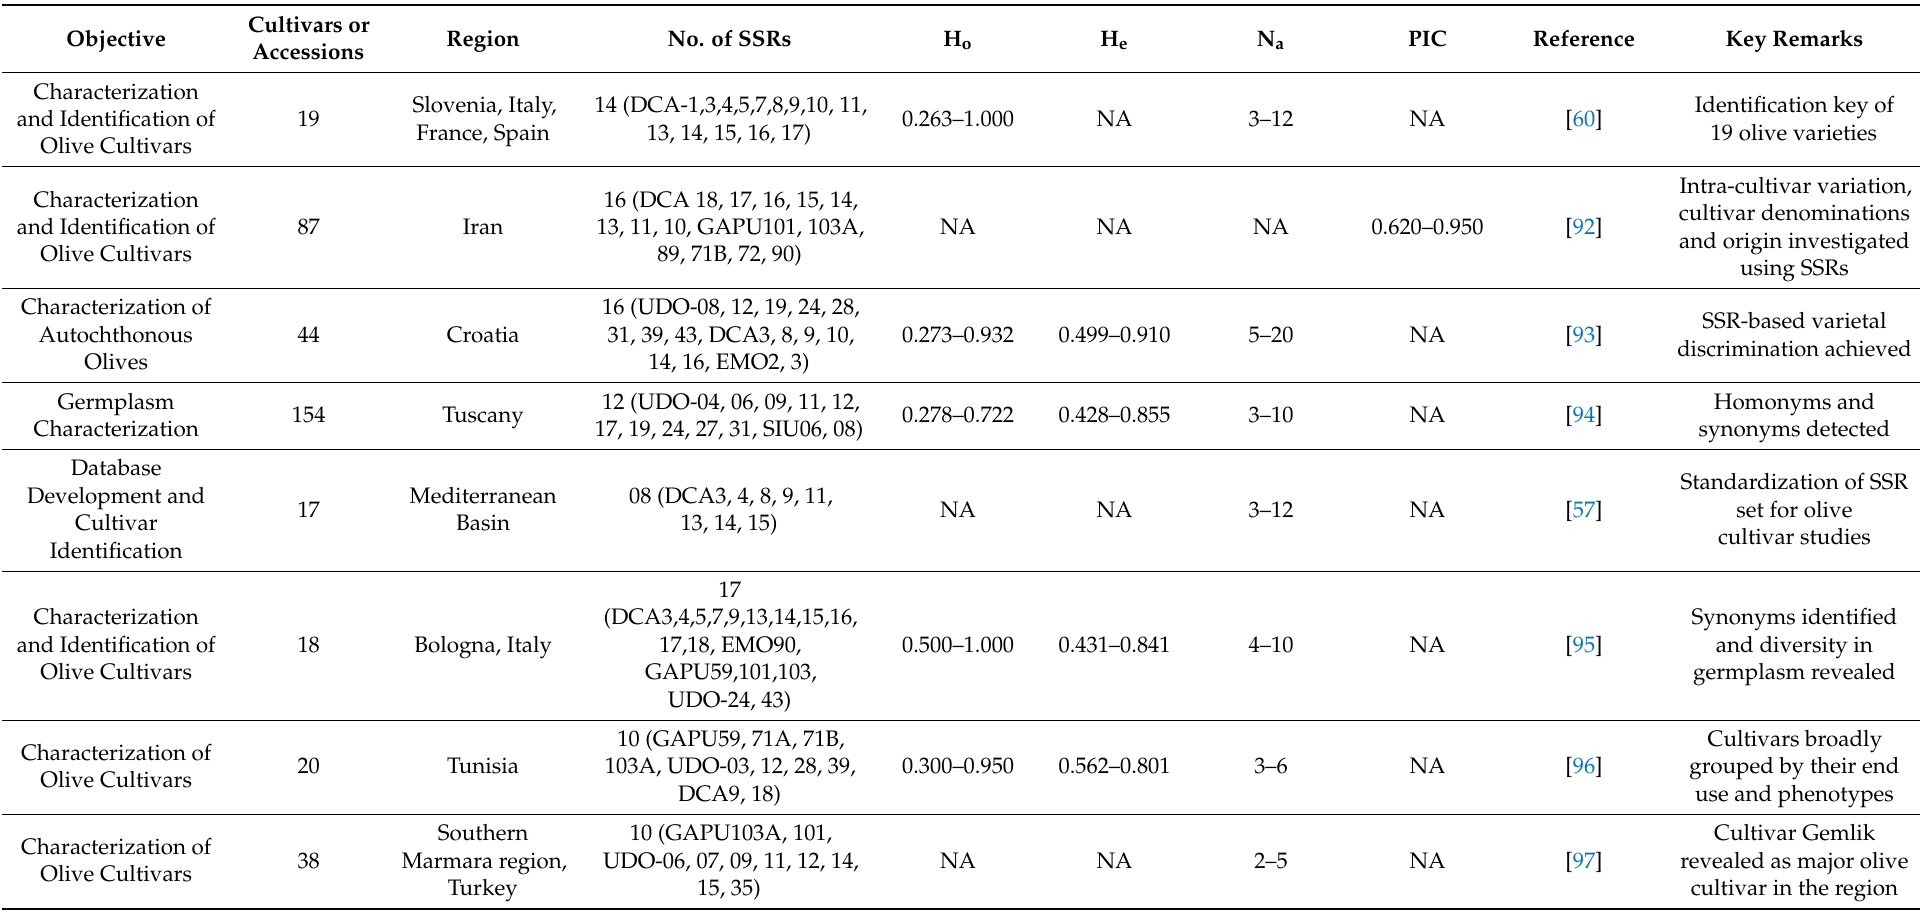
Table 2. List of studies highlighting applications of microsatellites in the characterization of olive genetic